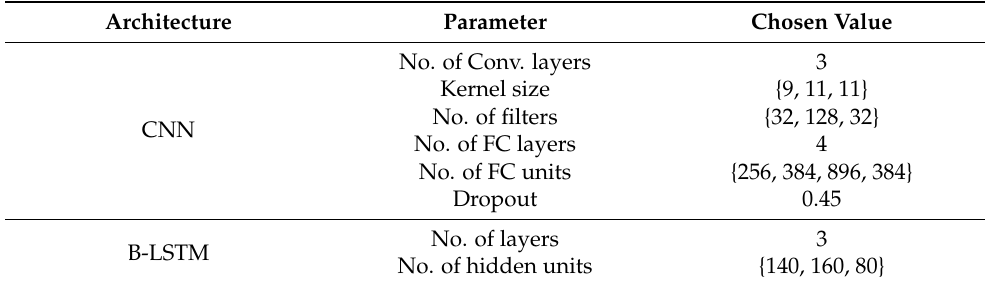
Table 2. The list of hyperparameters chosen by Hyperband each neural network